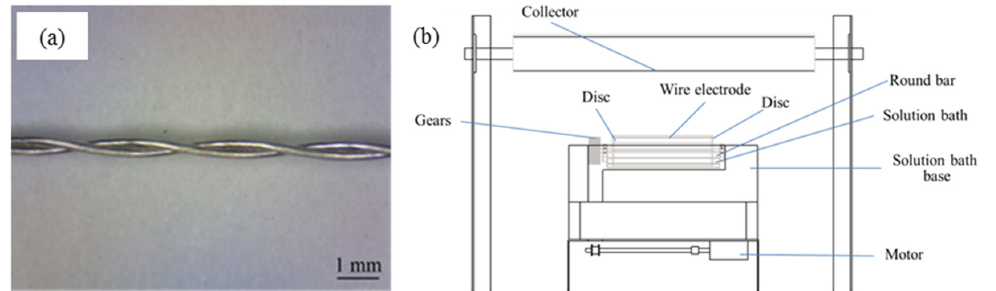
Figure 1. The mechanism of needleless electrospinning. ( a ) the image of a wire electrode and ( b ) the schematic drawing of electrospinning frame.